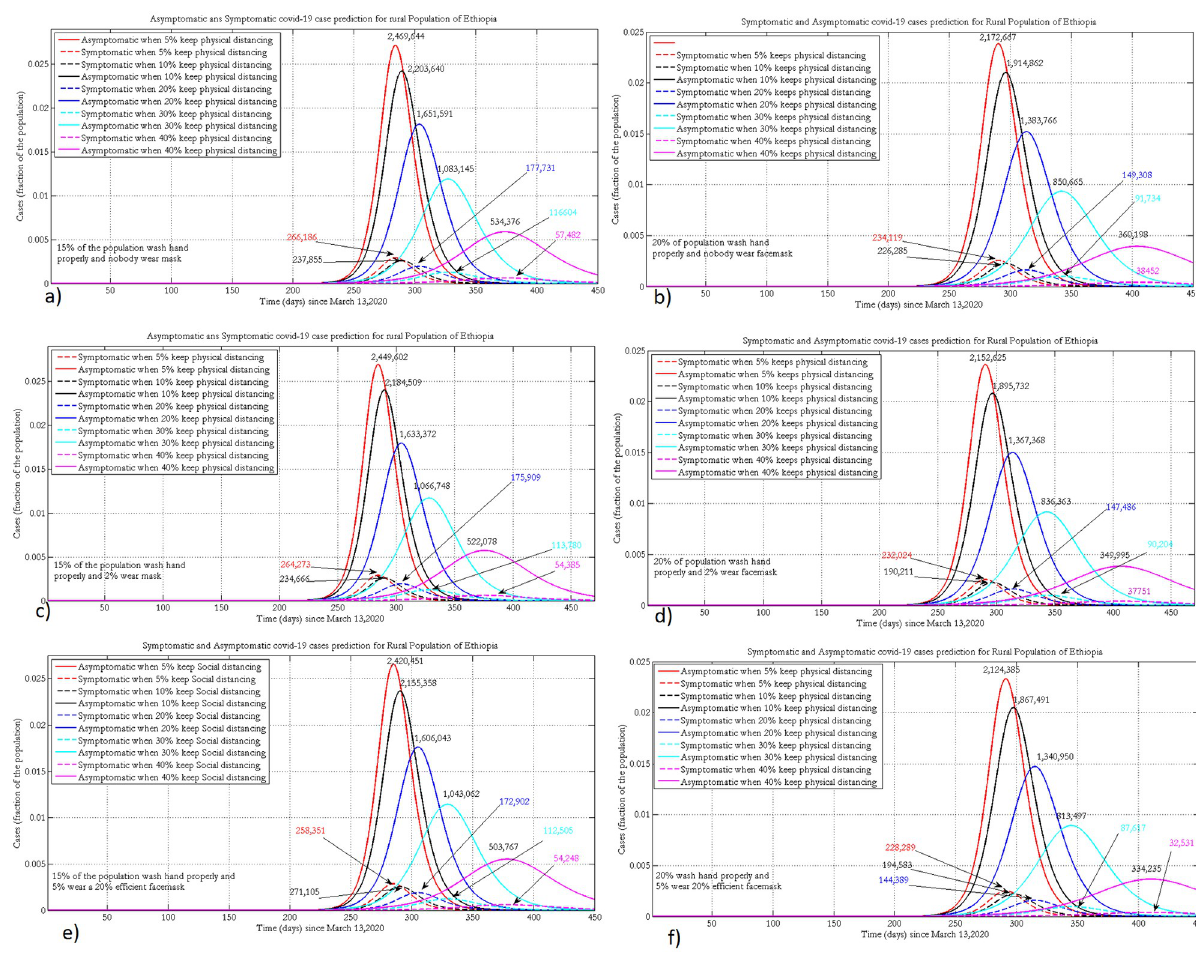
Fig 5. Projection of symptomatic and asymptomatic infectious cases in the rural population of Ethiopia when 15% or 20% practice hand washing and 0% (a, b), 2% (c, d) or 5% (e, f) of the population wear face masks, with 20% efficacy.